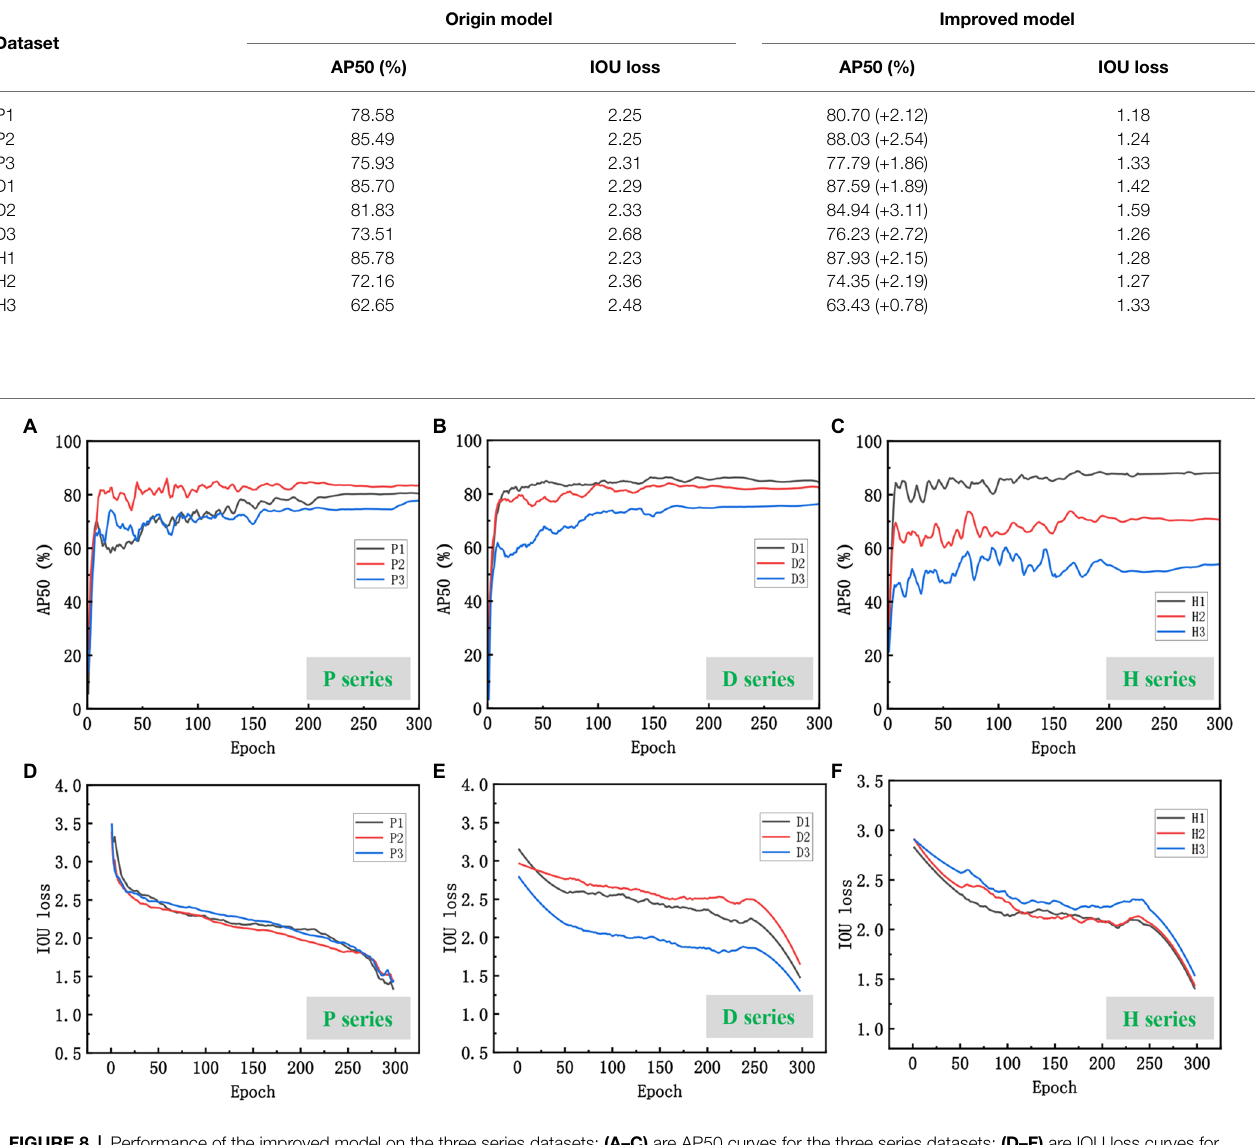
TABLE 3 | Comparison of accuracy and IOU loss between original and improved networks.